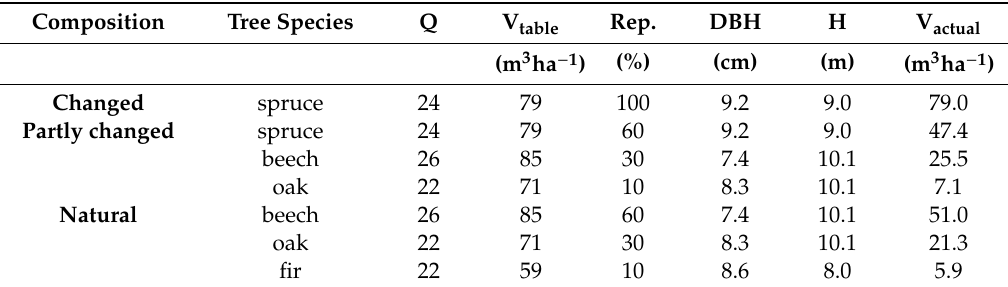
Table 1. The essential characteristics of the representative forest stands used to generate the virtual stand structure in the forest growth simulator SIBYLA at the age of 30 years. Composition Tree Species Q V table Rep. DBH H V